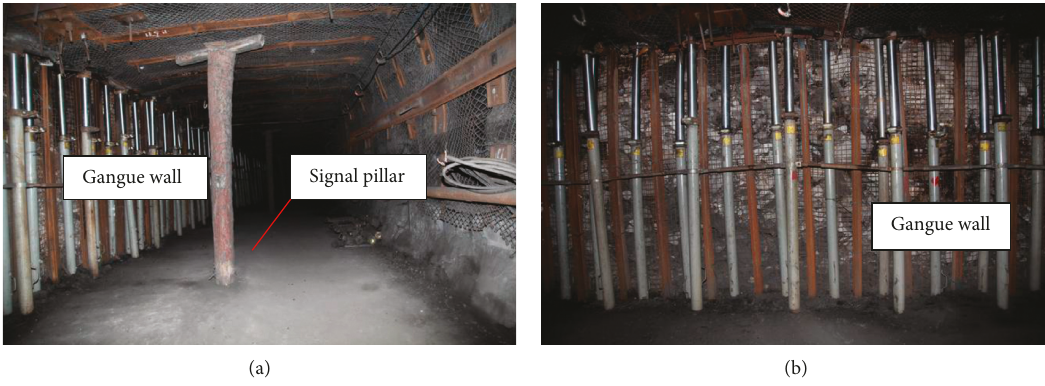
Figure 10: Field-retaining